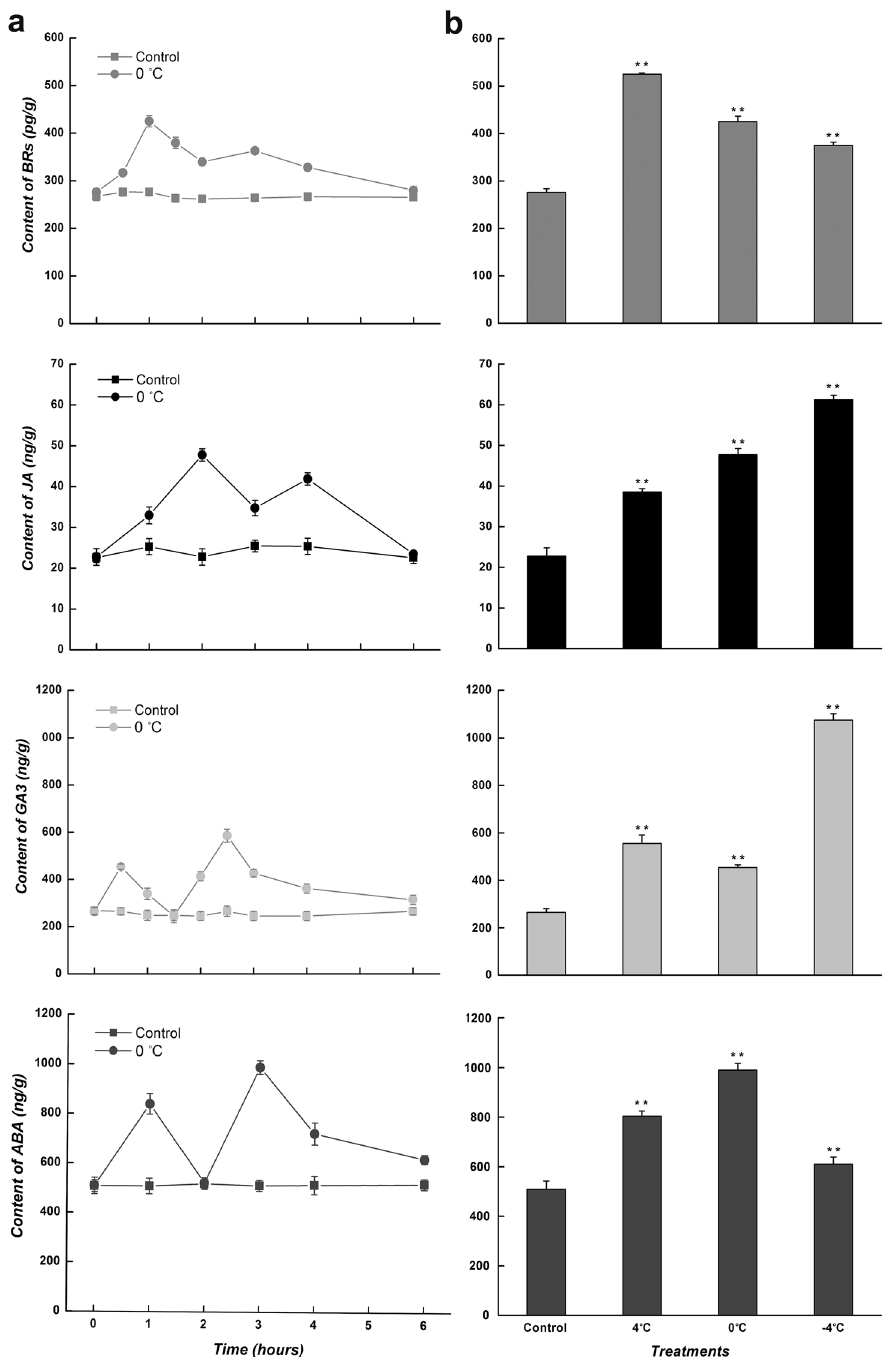
Figure 7. Pytohormone analysis in the leaves from C. bungeana regenerated plants at low temperatures. ( a ) Changes in the level of BRs, JA, GA3 and ABA at 0 °C. ( b ) Levels of BRs, JA, GA3 and ABA at different low temperatures (4, 0 and − 4 °C). The data of BRs and ABA were detected at being treated for 1 h, and those of JA and GA3 were detected at being treated for 2 and 0.5 h, respectively. The corresponding data at the same time point under normal conditions was taken as the control. Each value represents the mean ± SE of five